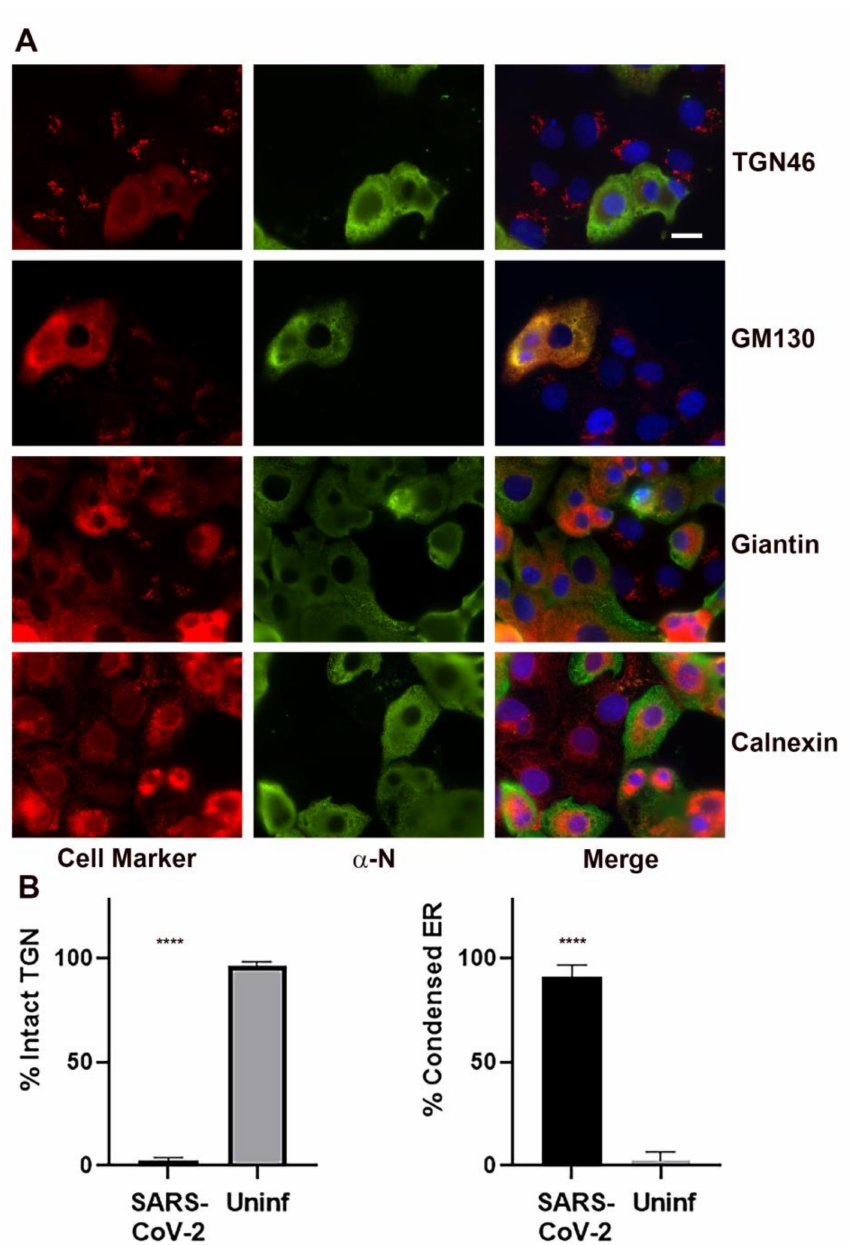
Figure 5. Immunofluorescent labeling for Golgi and ER markers in SARS-CoV-2 infected cells showing dissolution of the Golgi apparatus and compaction of the ER in infected cells. ( A ) Golgi specific markers include TGN46, GM130, and giantin. The ER was labeled with calnexin. Infected cells are labeled with an anti-nucleocapsid (N) antibody (green). Merged images are counterstained with DAPI (blue). Bar = 10 µ m. ( B ) Quantitation of the TGN46 observed in cells infected with SARS-CoV-2 vs. uninfected control cells. TGN46 localization was determined for 315 SARS-CoV-2 infected cells in three biological replicates and 522 uninfected control cells in five biological replicates. For ER condensation, 125 SARS-CoV-2 infected cells and 106 uninfected control cells in five biological replicates were analyzed. Shown is the mean ± the S.E.M. Statistics were performed using One-way ANOVA. Significant differences relative to the uninfected control are indicated (**** p <